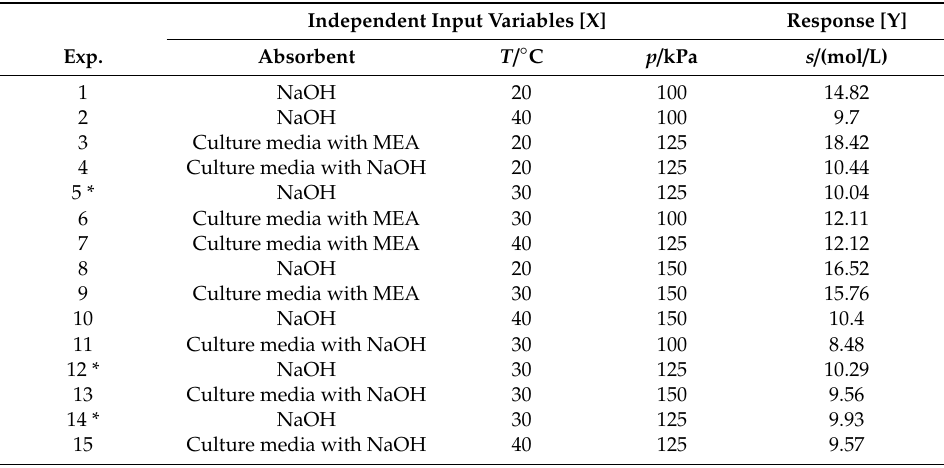
Table 3. Actual response of CO 2 concentration at experimental design points.